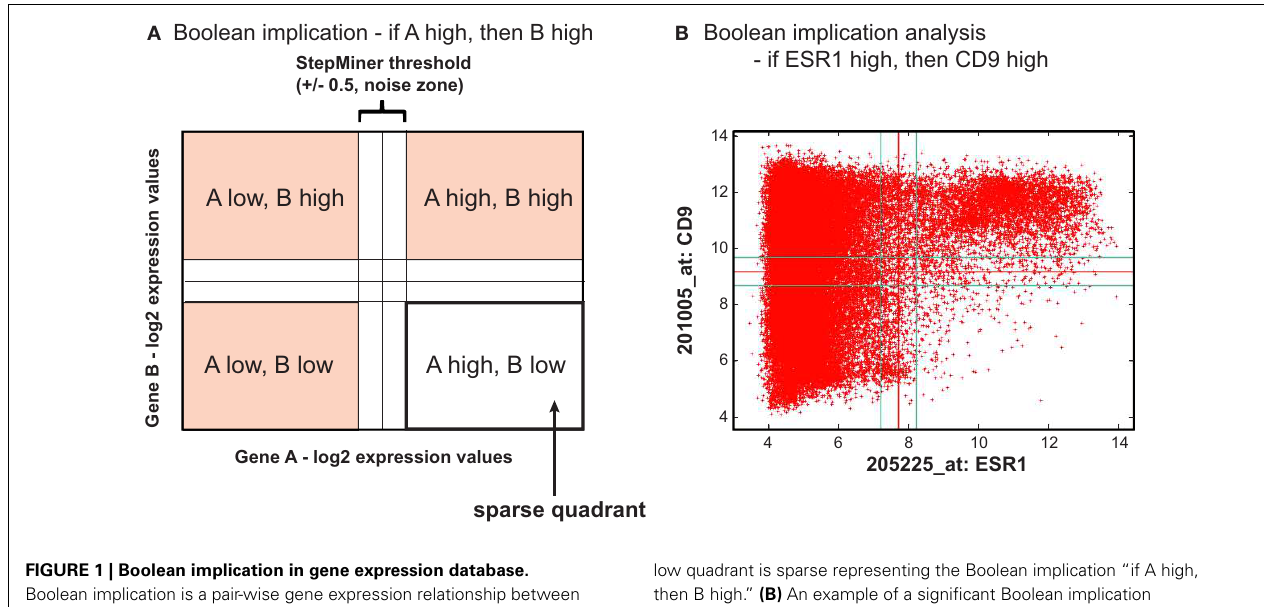
FIGURE 1 | Boolean implication in gene expression database. Boolean implication is a pair-wise gene expression relationship between two genes with respect to their gene expression values. (A) Schematic example of a Boolean implication between two genes A and B.Threshold to separate high and low gene expression values are computed using StepMiner. A noise margin of 0.5 is used for statistical calculations. Each of the four quadrant is tested for their sparsity. In this case, A high and B